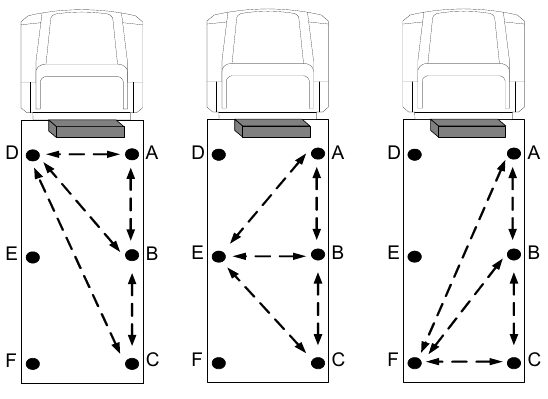
Figure 10. Allocation of approximation platform.